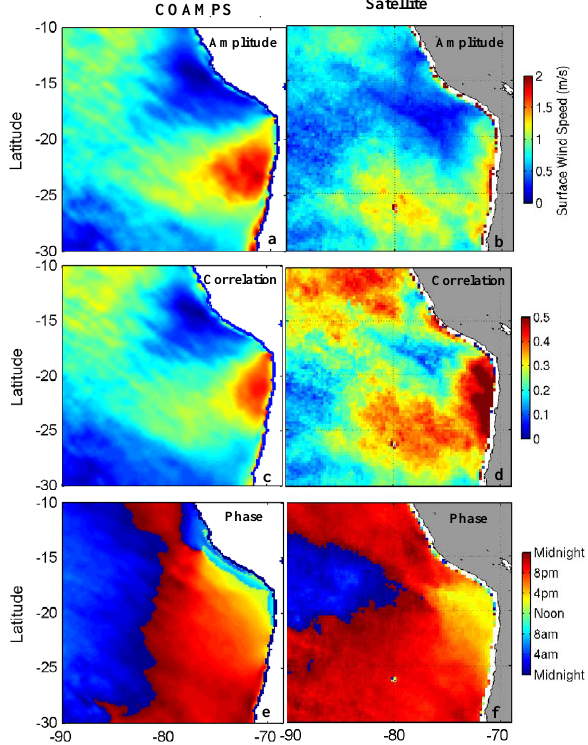
Fig. 5. The same as in Fig. 4 except for the surface wind speed and the correlation coefficient ranges 0–0.5 now. Note that the scale in the color coding used for the correlation coefficients is different from the corresponding one used in Fig. 3c and d.